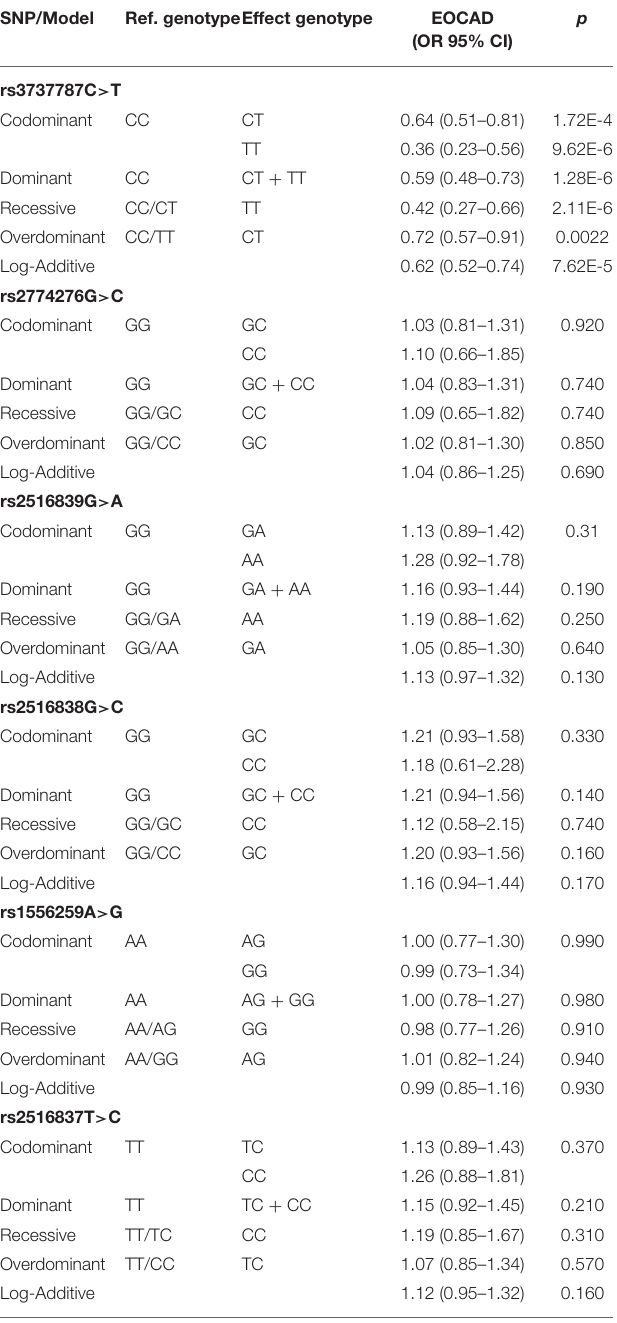
TABLE 4 | Genotypes of the six USF1 SNPs and the risk of EOCAD. TABLE 5 | Associations between the dominant model of rs3737787 and the risk of EOCAD in men and women